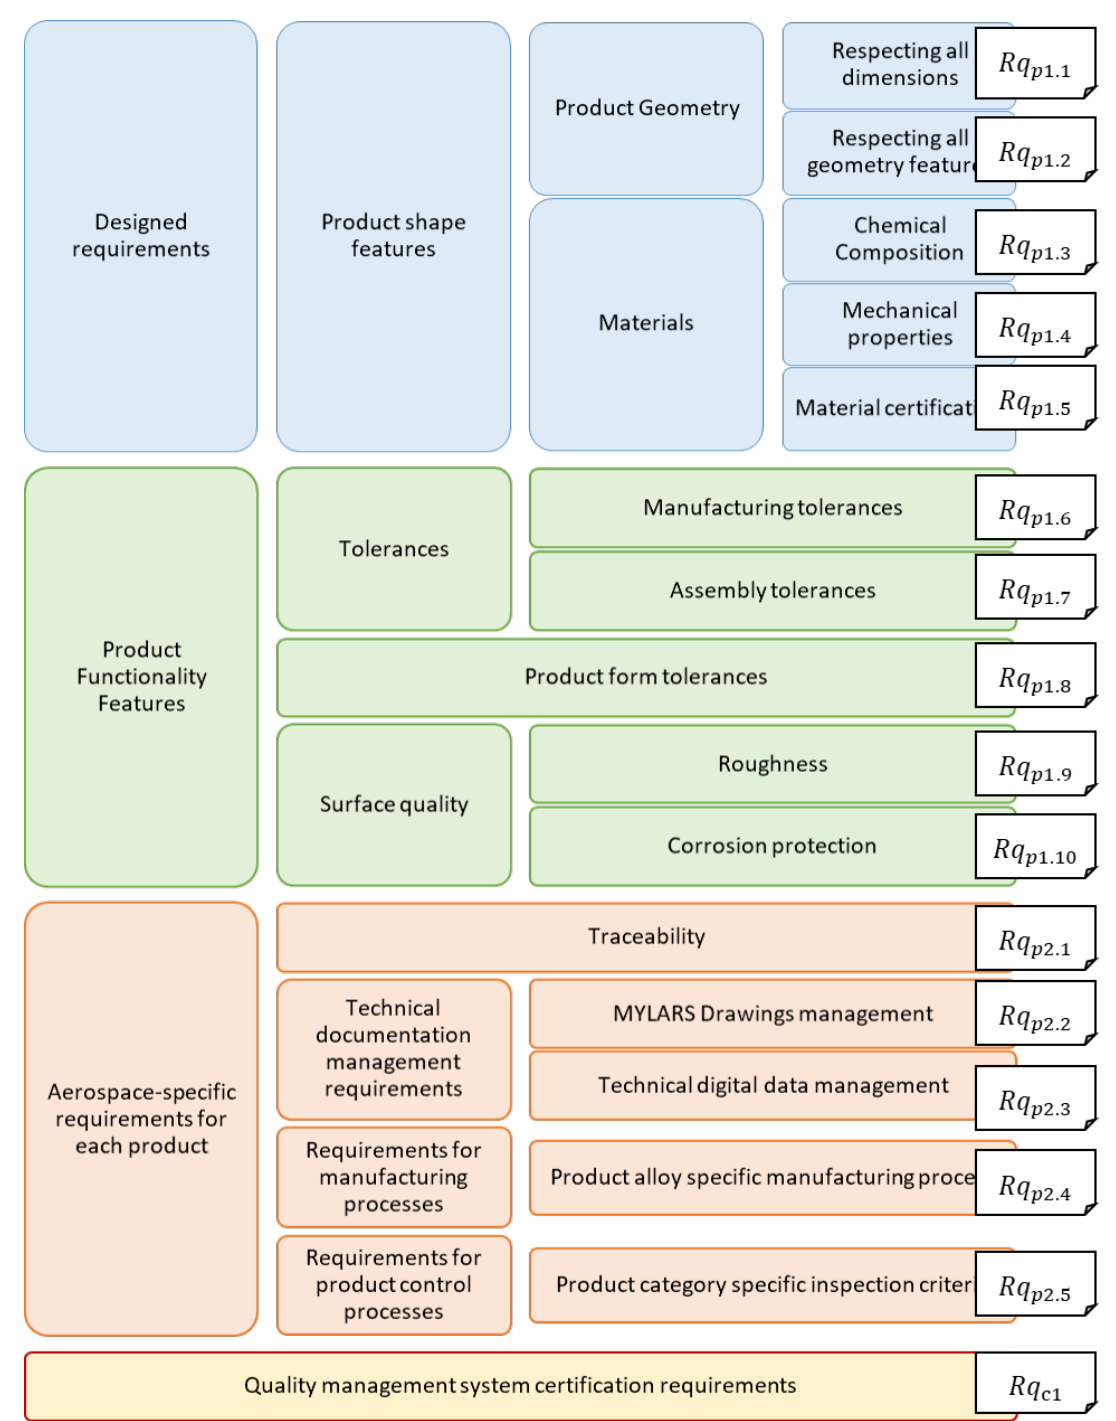
Figure 12. Levels of aerospace structural product quality requirements and their coding.